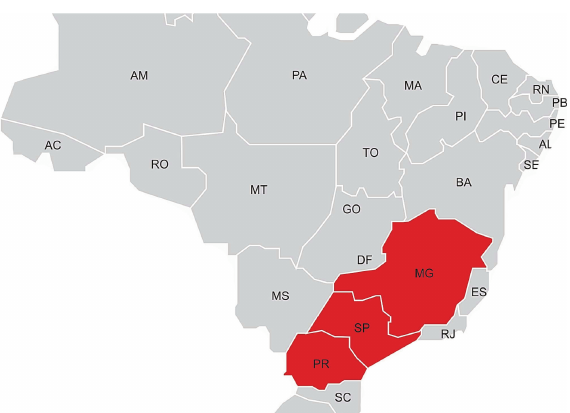
Figure 1: Map of Brazil highlighting SP, PR and MG